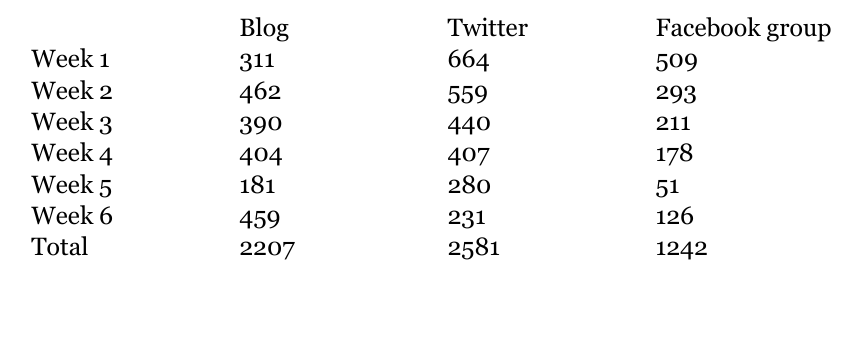
Interaction Data (Posts and Comments) of Each Week in Different Spaces